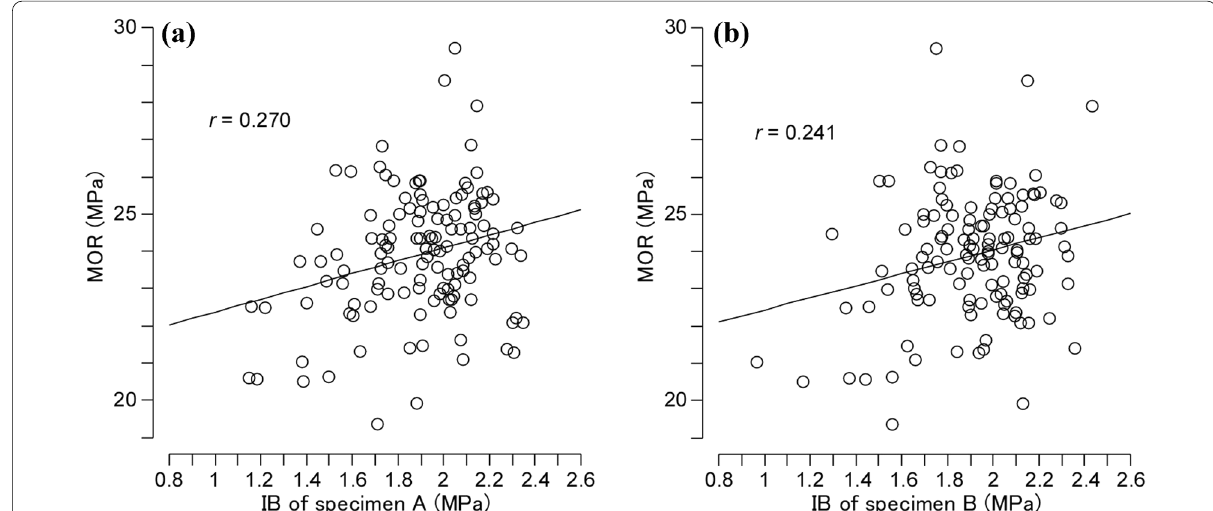
Fig. 7 a The relationship between internal bond (IB) of specimen A and modulus of rupture (MOR). b The relationship between IB of specimen B and MOR. r: correlation